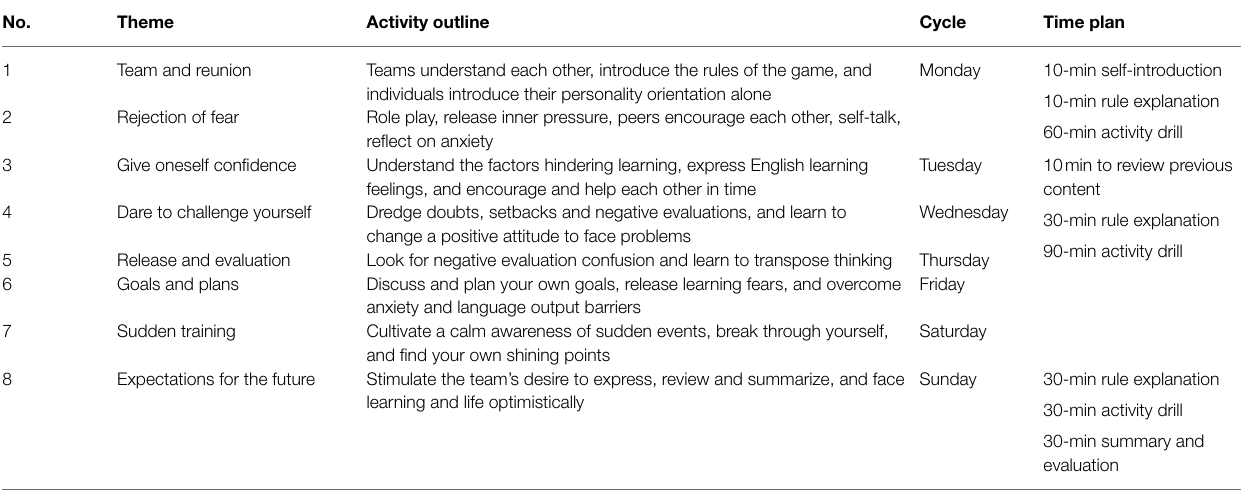
TABLE 3 | Activity summary and cycle.